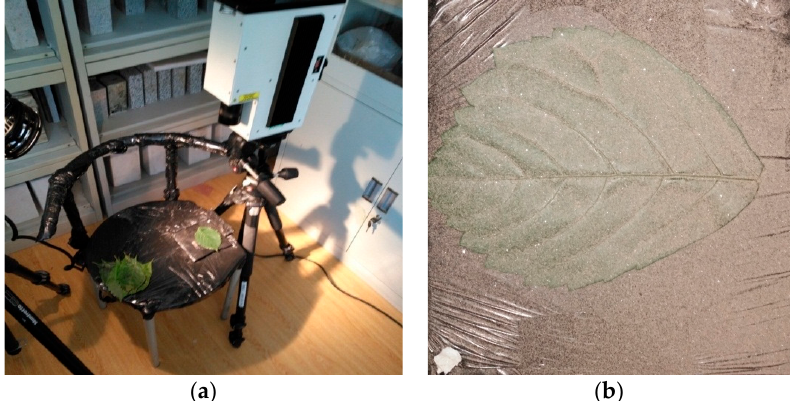
Figure 2. Device for measuring the spectrum of dusty leaves in the dust falling experiment. ( a ) is a photo of the experimental setup. ( b ) is a leaf covered with a certain amount of dust.